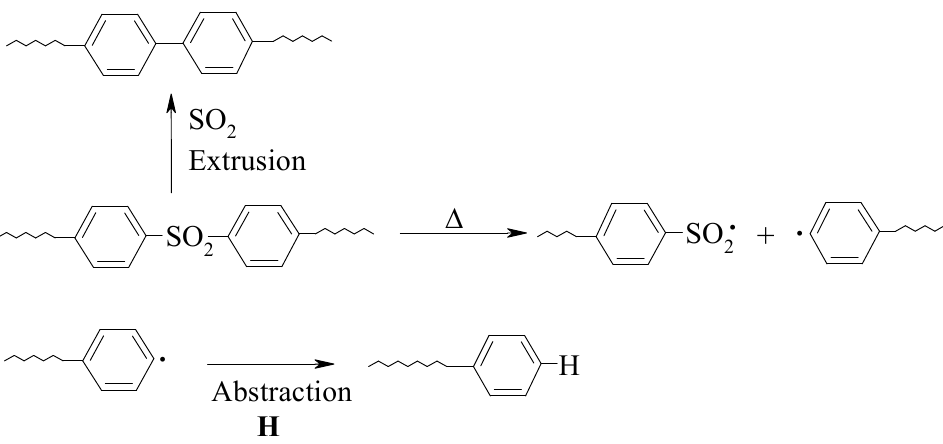
Scheme 2. Thermal degradation mechanisms involving diphenyl ether moieties, ( a ) cleavage of the Polymers 2020 , 12 , x 9 of 26 diphenyl ether bridges, ( b ) dehydrogenation process and formation of dibenzofurans.